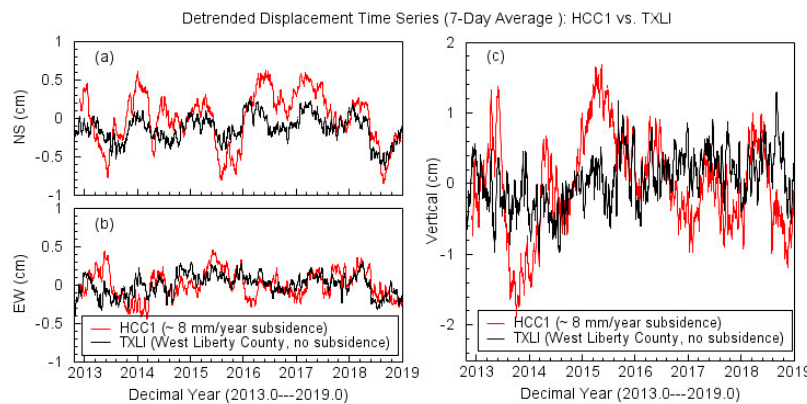
Figure 15. Comparisons of the seasonal horizontal and vertical ground deformation at two sites: HCC1 (subsiding) and TXLI (no subsidence). The detrended displacements are derived from daily PPP solutions. Remote Sens. 2019 , 11 , x FOR PEER REVIEW